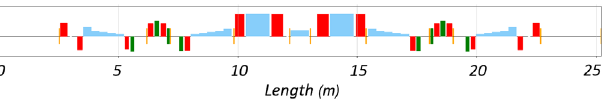
FIG. 5. The PETRA IV cell (a seven-bend achromat of ESRF- EBS type) that consists of bending magnets, shown in blue, focusing and defocusing quadrupoles, shown in red, and focusing (sf) and defocusing (sd) sextupoles, shown in